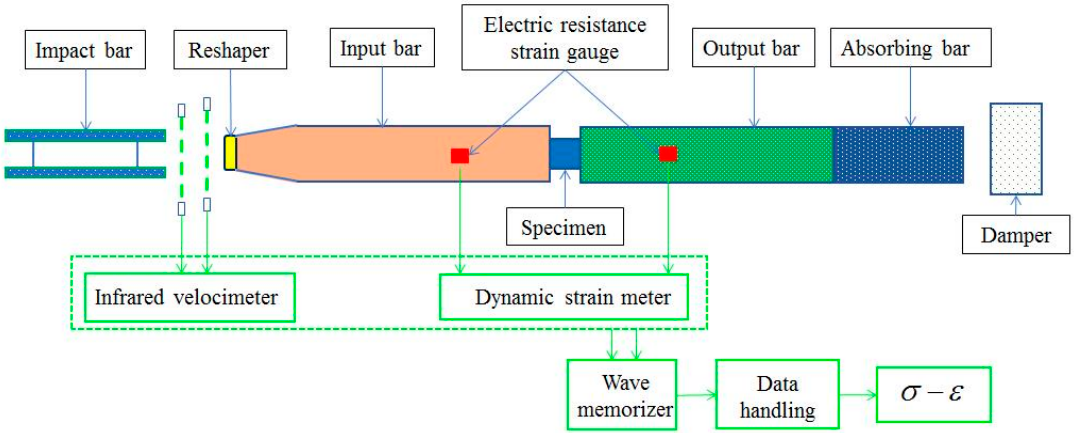
Figure 4. The schematic diagram of SHPB measurement.